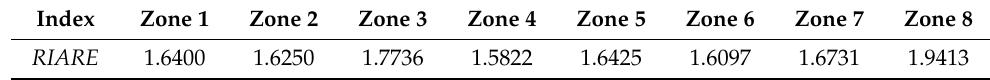
Table 3. Indices for RIARE in reference tracking simulation. Table 2. Indices for IARE in reference tracking simulation.